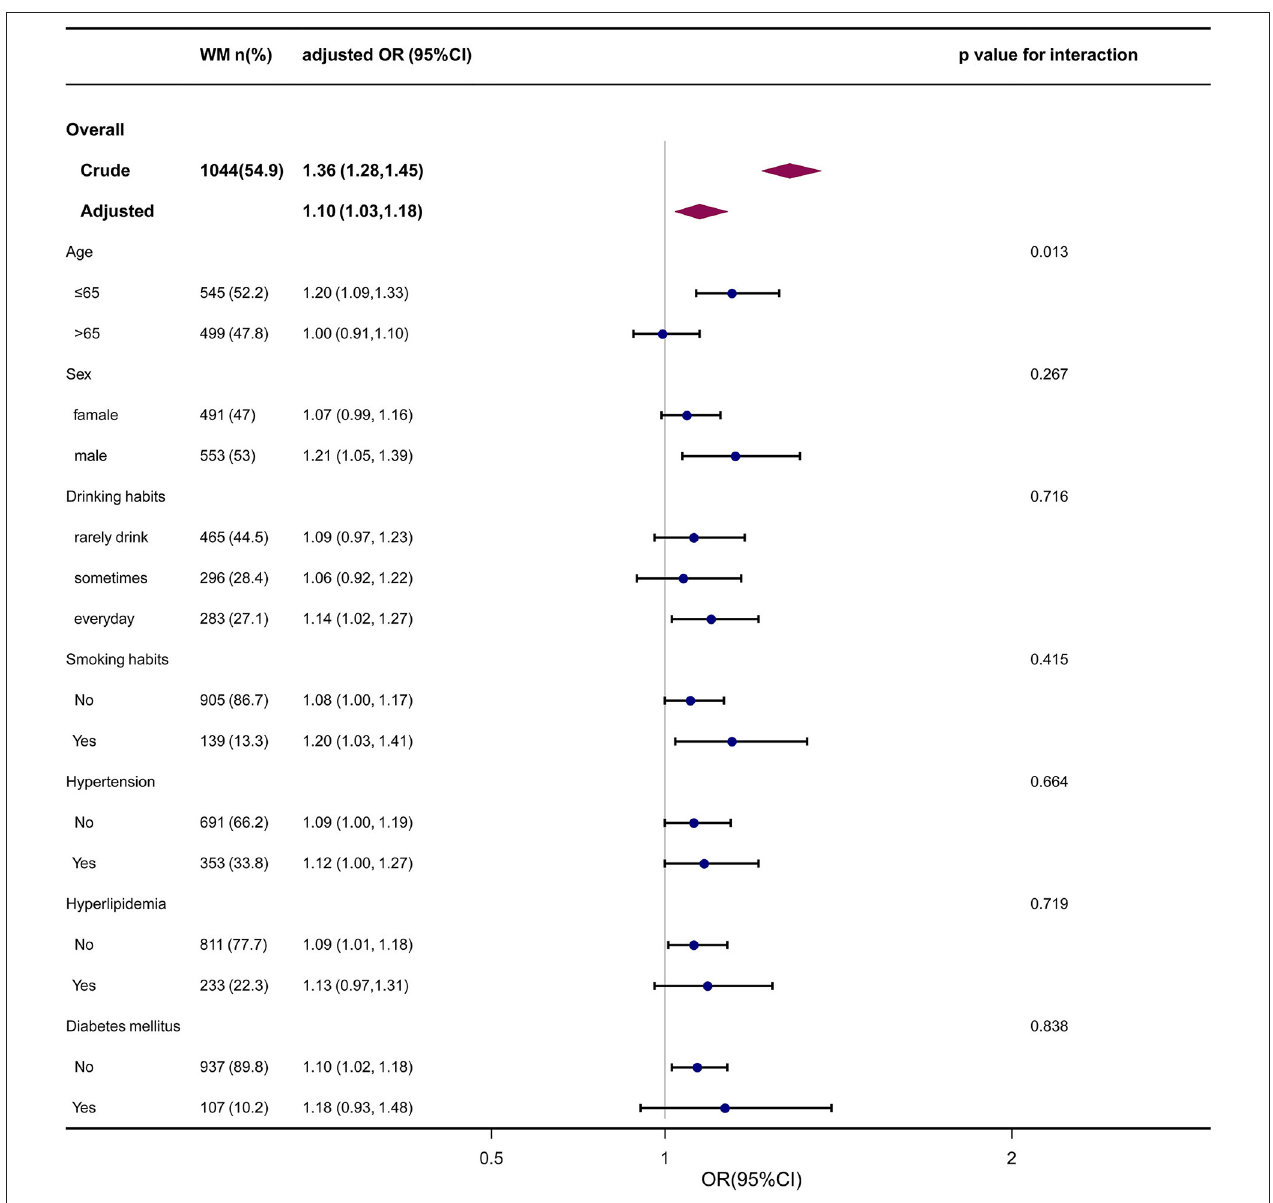
FIGURE 3 | The forest plot of the association between PS and WMH according to baseline characteristics. P -value represents the likelihood of interaction between the variable and the PS. PS, carotid plaque score, WMH, white matter hyperintensity; OR, odds ratio; CI, confidence